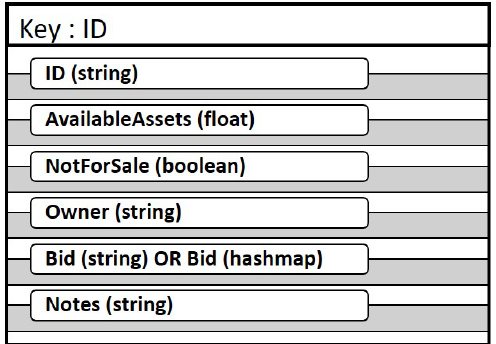
Figure 3. Structure of